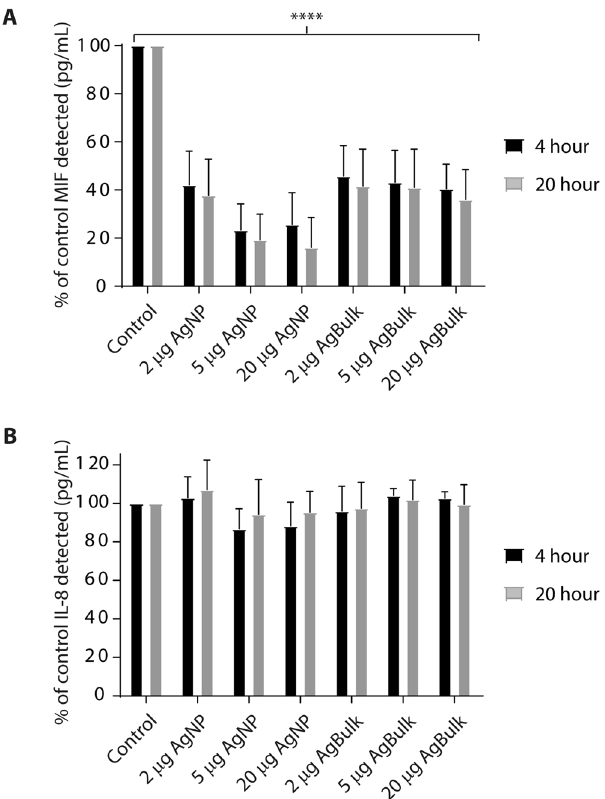
Figure 6. The impact of silver nanoparticles on cytokine detection. Recombinant MIF ( A ) or IL-8 ( B ) (250 pg/ml) was incubated without (Control) or with 2, 5 or 20 µ g AgNP or Ag Bulk particles per 10 5 cells in culture medium containing autologous serum for 4 or 20 hr at 37 °C. The concentration of MIF or IL-8 in the clarified culture medium was assessed via ELISA. Data is expressed as the percentage of control cytokine concentration ± SEM, n = 3; * p < 0.05; *** p <